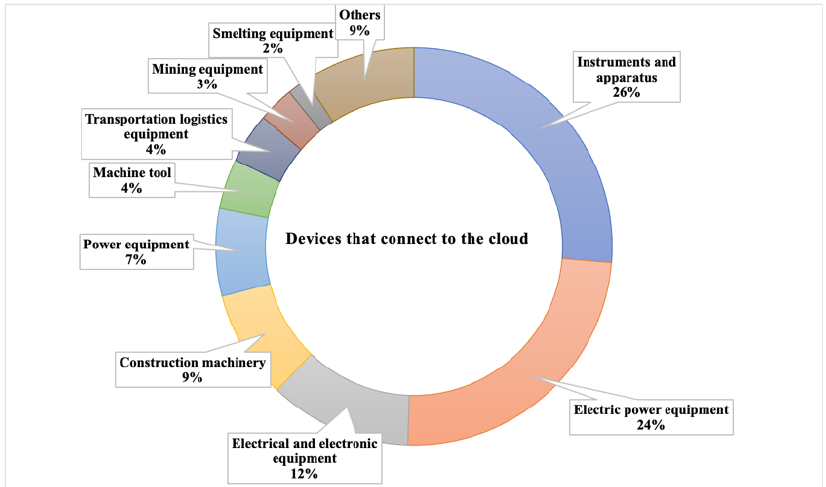
Figure 4. Distribution of industrial equipment connected to the cloud in 2020.